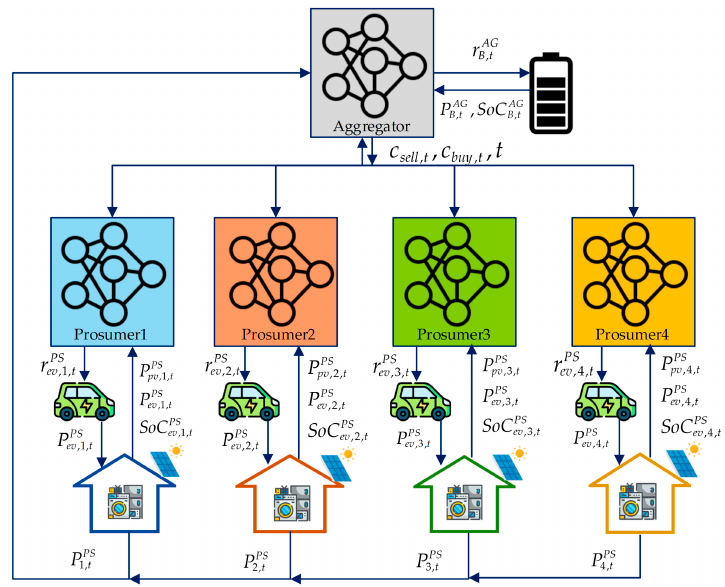
Figure 2. The proposed DDPG with MDP framework.